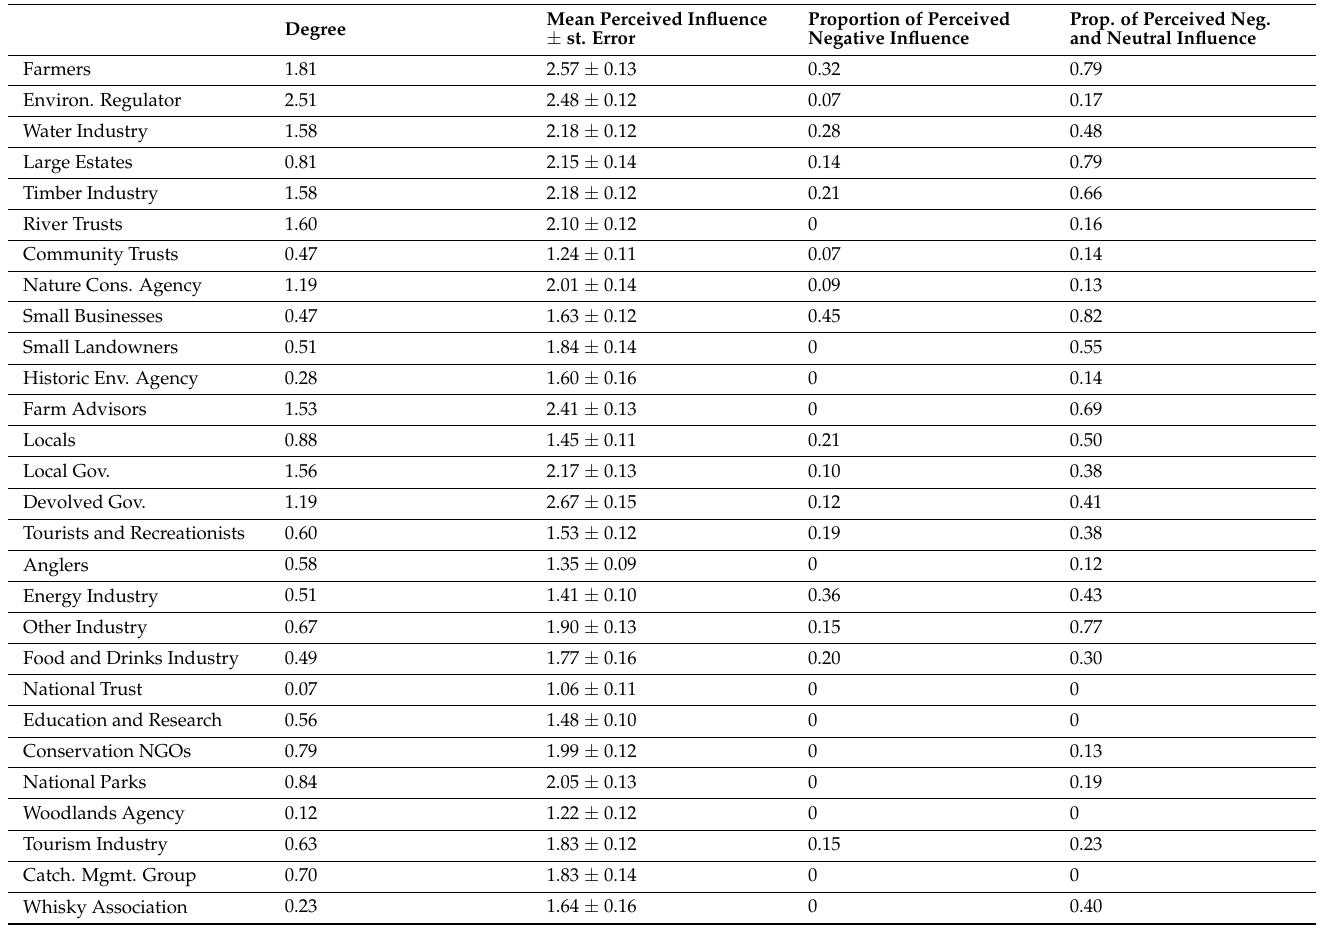
Table A1. Degree, mean perceived influence, and proportion of perceived negative influence, and combined negative and neutral influence of the 28 elicited